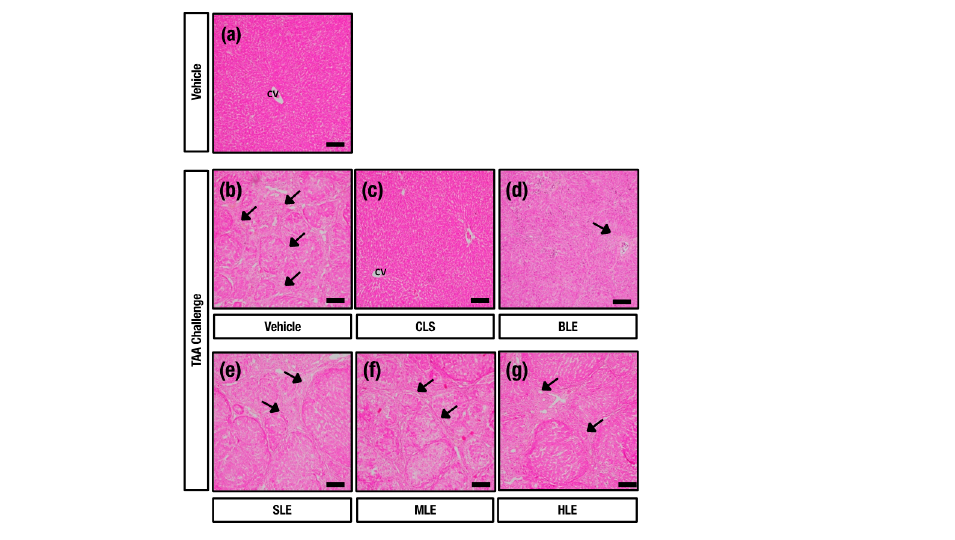
Figure 4. Hepatoprotective effect of aqueous extracts (CLS and BLE) against TAA-induced liver cirrhosis. Histopathological sections of livers (stained with HE) from HC, DC and different leaf extract treatments of O. octandra CLS, BLE and SLE) after 15 weeks. ( a ) HC livers showed normal hepatic architecture and without histopathological changes. ( b ) Regenerating hepatic nodules formed by complete fibrous bridges were seen in the livers of DC. ( c ) Animals treated with CLS showed normal hepatic architecture. ( d ) Incomplete fibrous bridge formation was seen in the animals treated with BLE. ( e – g ) Complete fibrous bridge formation with regenerating hepatocytes was observed in animals treated with SLE, MLE and HLE, respectively. CV, central vein. Bar = 100 µm.